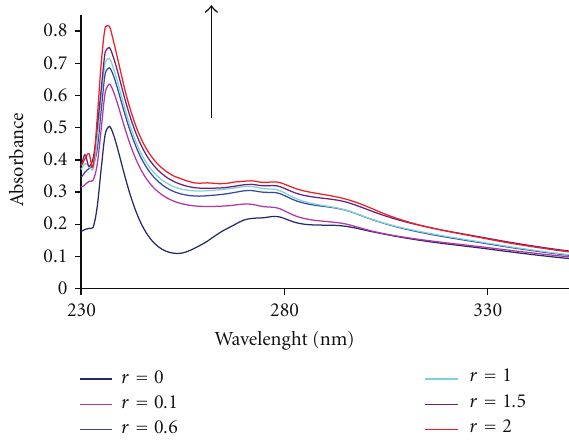
Figure 3: Absorption spectra of Pt(II) complex (5 × 10 − 5 M) in the absence and presence of increasing amounts of CT DNA: r i = 0.0, 0.1, 0.6, 1. 1.5, and 2.